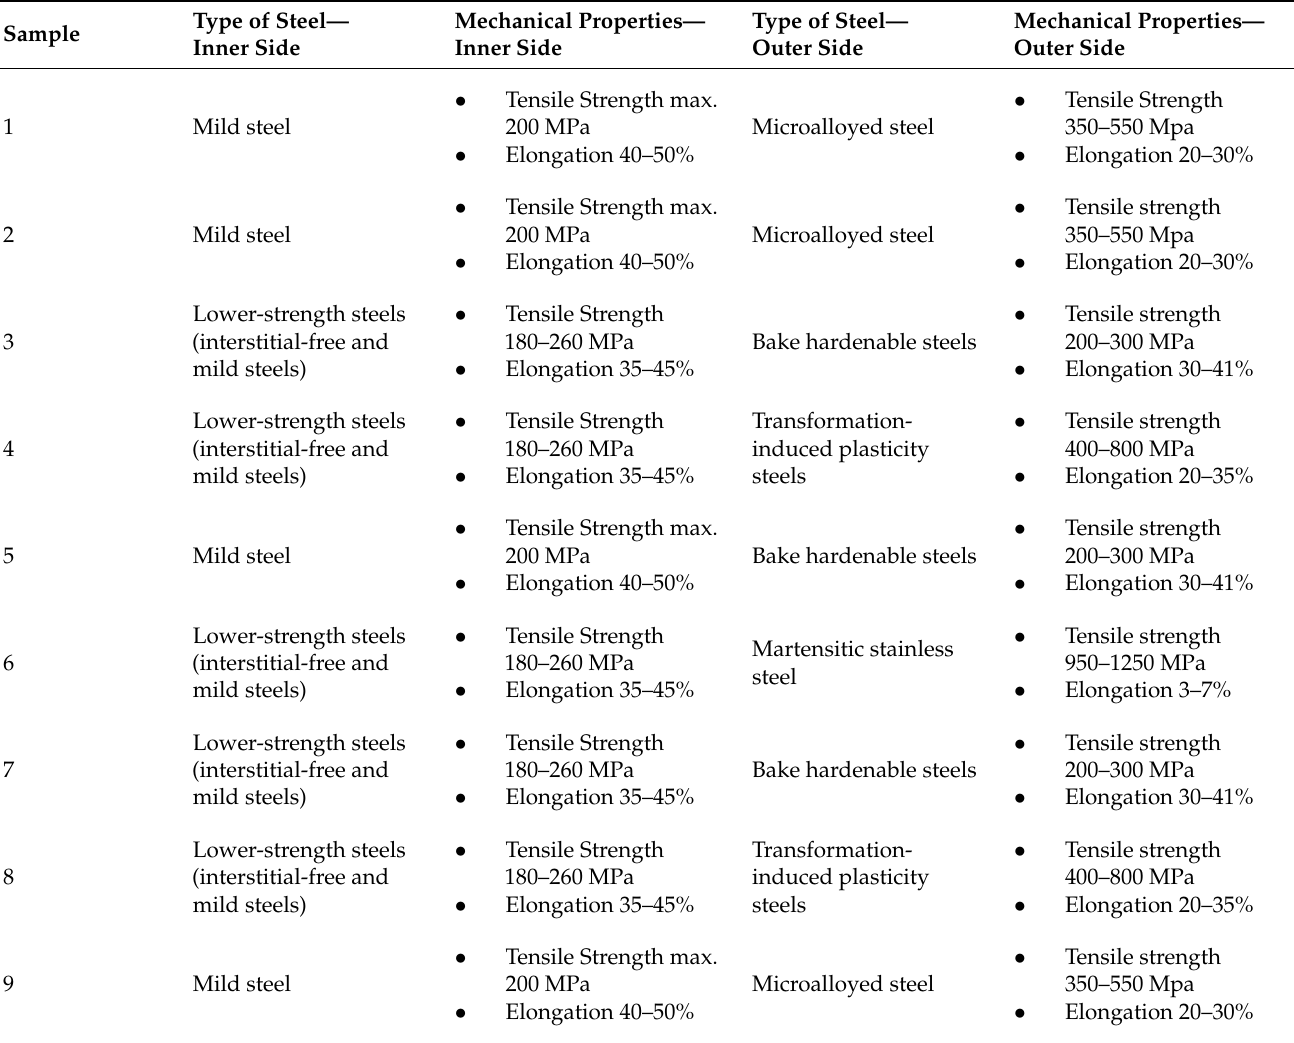
Table 2. Type “B” pillar sample analysis in terms of the steel type used